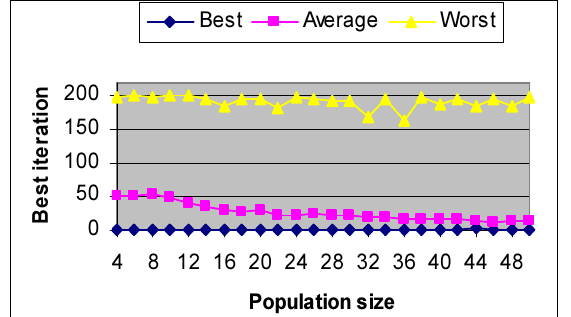
Fig. 14. Dependency of the convergence rate on the popu- lation size Comparison of all obtained objective value results